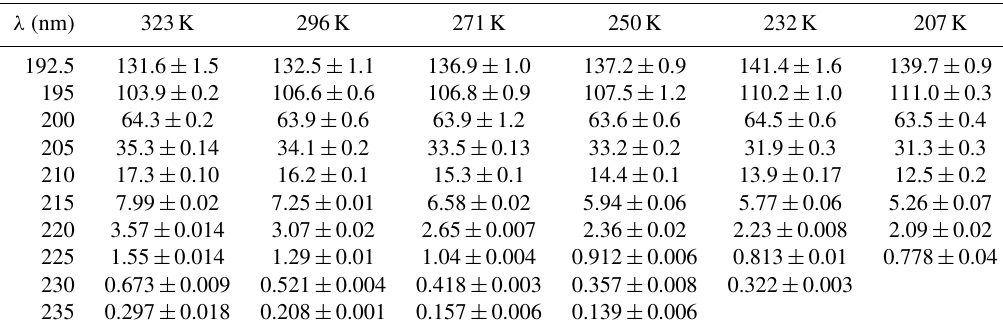
Table 1. CCl 3 CF 3 (CFC-113a) UV absorption cross section data (10 − 20 cm 2 molecule − 1 , base e) obtained in this work.